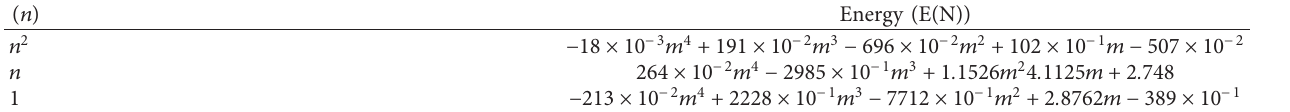
Table 2: All aforementioned are derived from the coefficient of the curves given in Table 1.